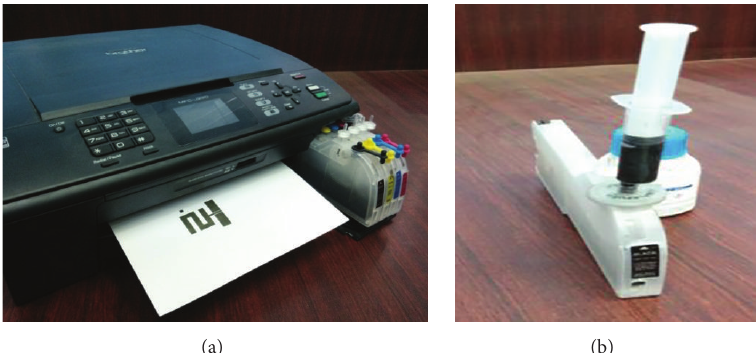
Figure 1: (a) Brother inkjet printer with the printed antenna. (b) Filling cartridge with conductive silver nanoparticles ink using syringe and